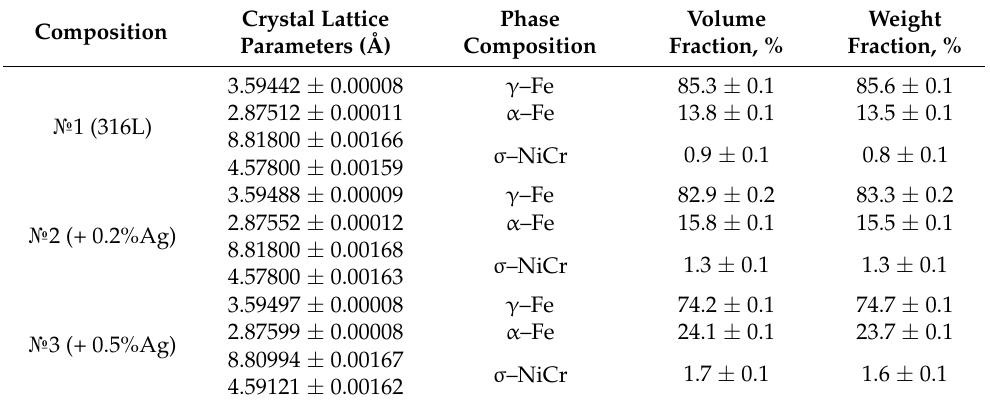
Table 3. Phase composition and parameters of the crystal lattice of 1-mm wire.